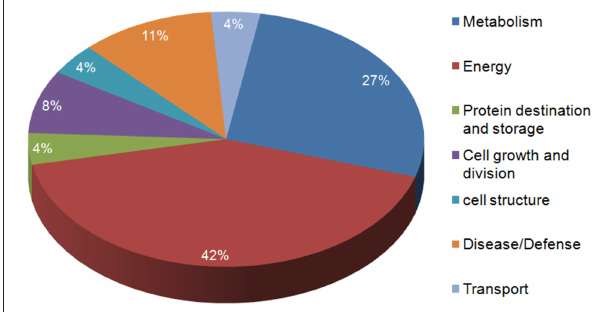
FIGURE 5 | Functional characterization of the identified